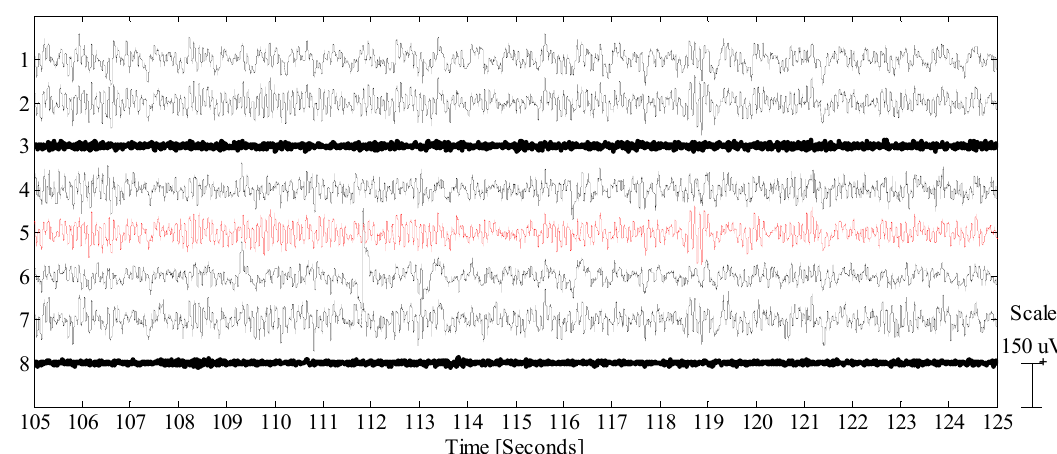
Figure 8. Alpha wave test. In red are the electrodes selected for the spectra analysis. In bold are electrodes not in good contact.